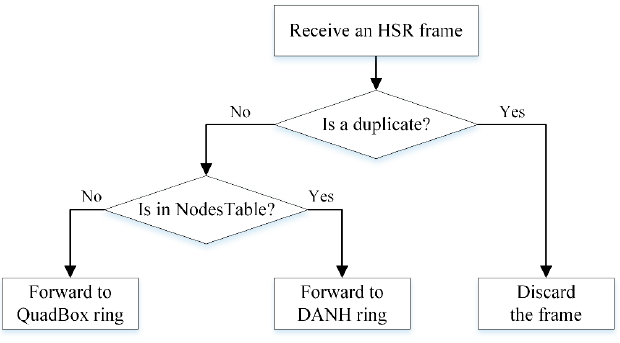
Figure 5. Process of forwarding a unicast frame in access QuadBoxes in eEFA. eEFA: Enhanced effectively filtering approach.